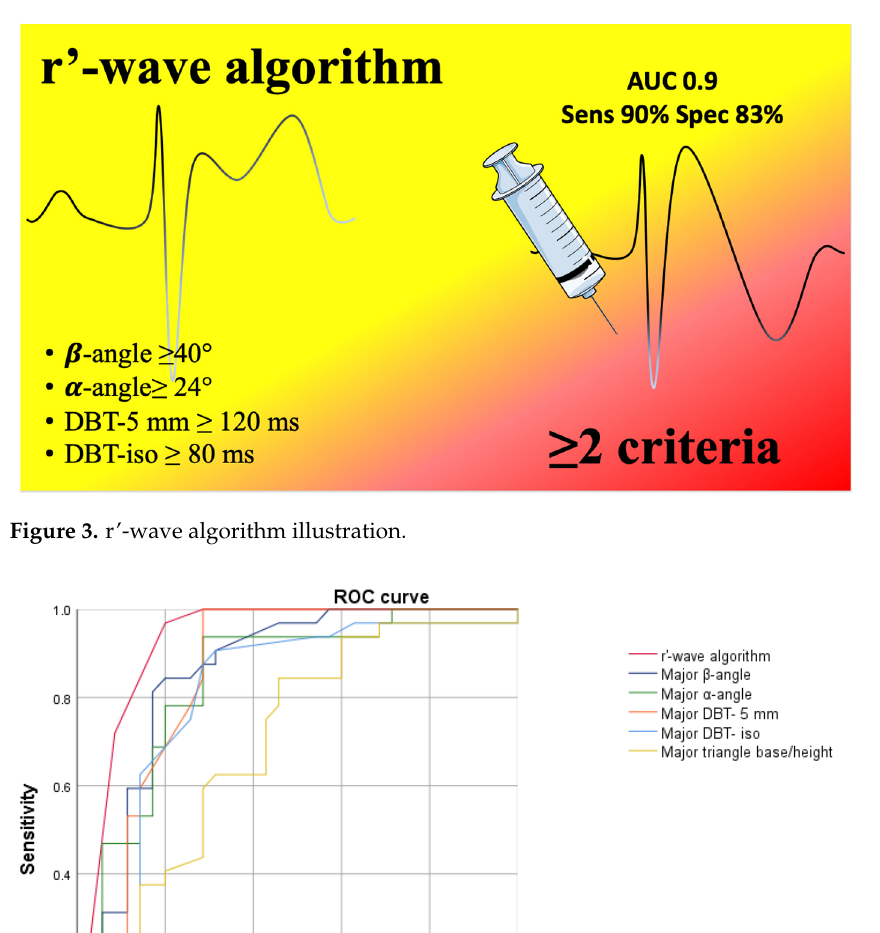
Figure 2. Receiver operating characteristic analyses of β -angle, α -angle, DBT- 5 mm, DBT- iso, and triangle base/height ratio to identify a BrS diagnosis after Sodium Channel Blocker Provocation Test in the test cohort.